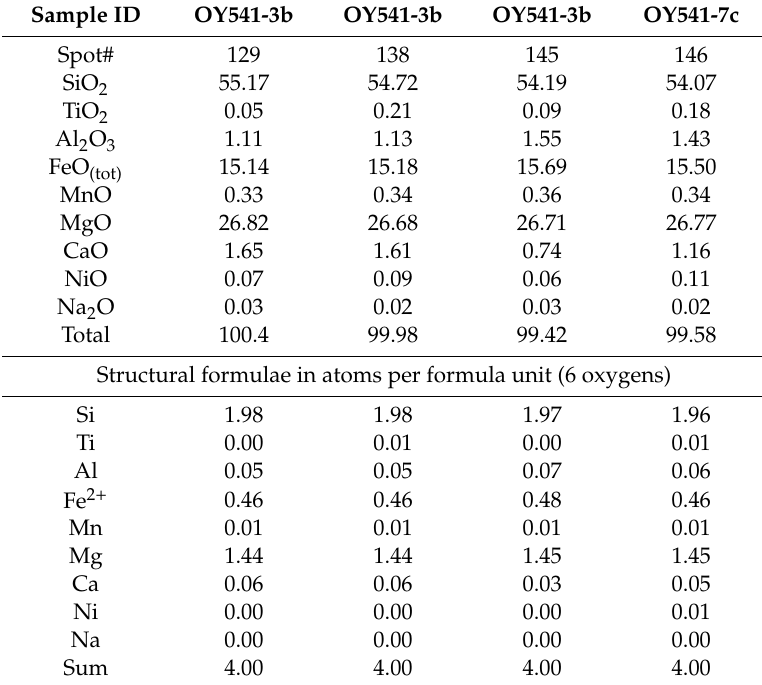
Table 3. Representative compositions of orthopyroxene relics in clinopyroxene measured by electron microprobe.